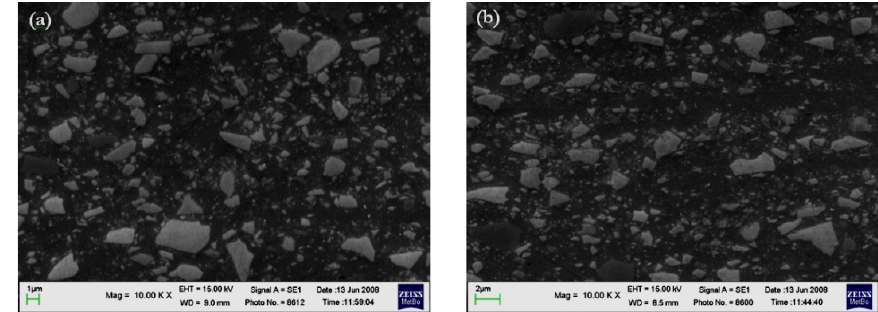
Figura 11: Micrografie SEM del composito AMC225xe saldato mediante LFW: (a) materiale base, (b) centro della saldatura